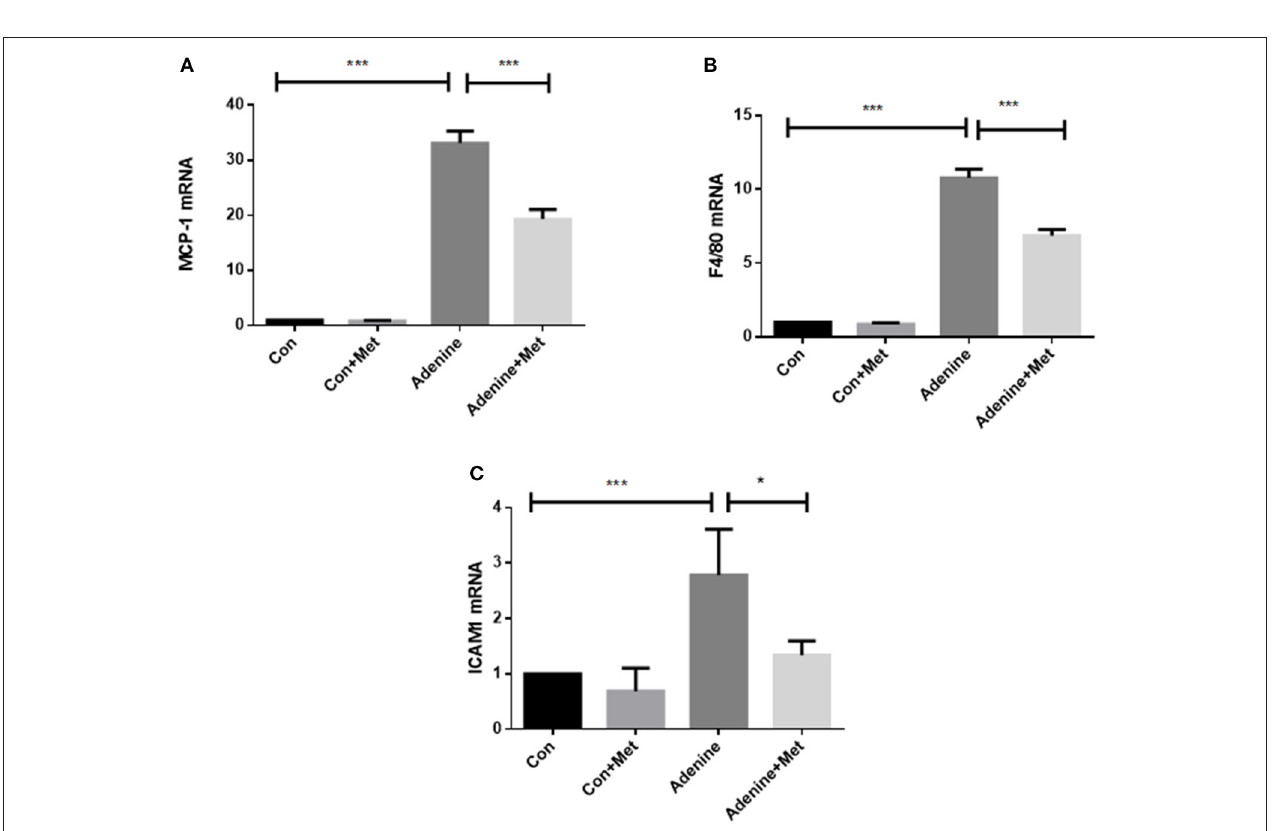
FIGURE 3 | Metformin prevents inflammatory responses in a mouse model of adenine-induced renal injury. qRT-PCR results showed that the mRNA expression of MCP-1 (A) , F4/80 (B) , and ICAM1 (C) were significantly increased in adenine treated mice compared to the control mice, which were reduced by metformin treatment. Data are expressed as mean ± SEM. * P < 0.05, *** P < 0.001, n =